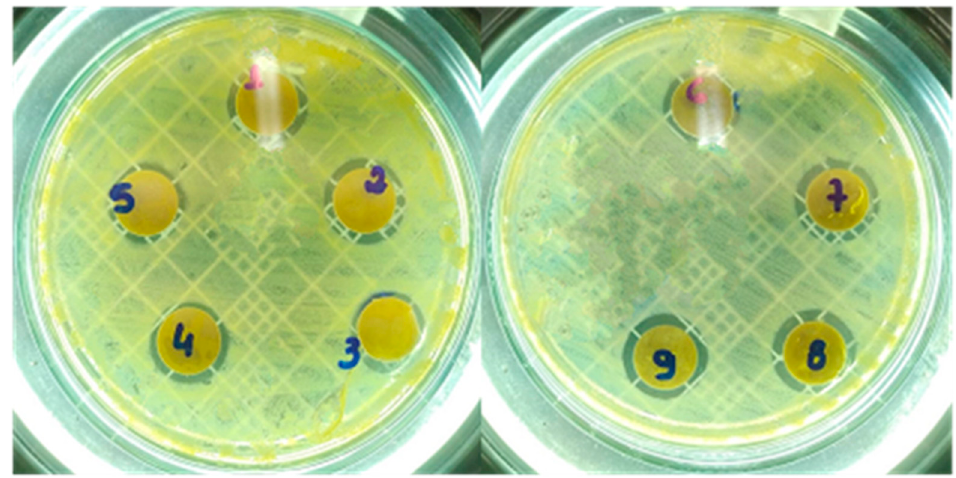
Figure 5. Photographs of halos of inhibition formed in tests against Staphylococcus aureus . *MgO-CP (labeled as 1,2,3); MgO-Av (labelled as 4,5,6); MgO-St (labeled as 7,8,9). Table 2. Average mean zones of inhibition (in mm) produced by synthesized MgO samples on the test organisms.